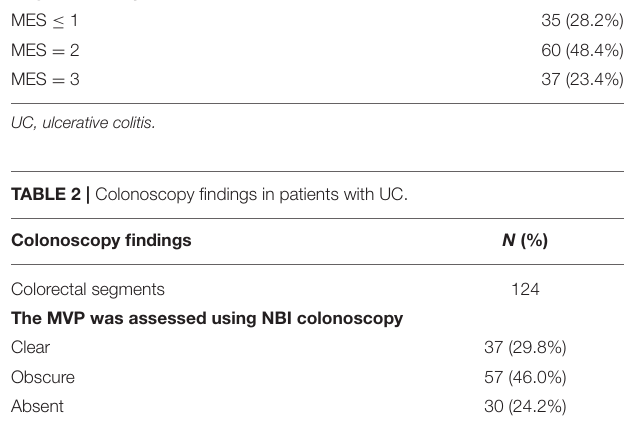
TABLE 6 | Area under the receiver operating characteristic (ROC) curve (AUC), sensitivity, specificity, and Youden index for defined endoscopic and histological healing (HH) in patients with